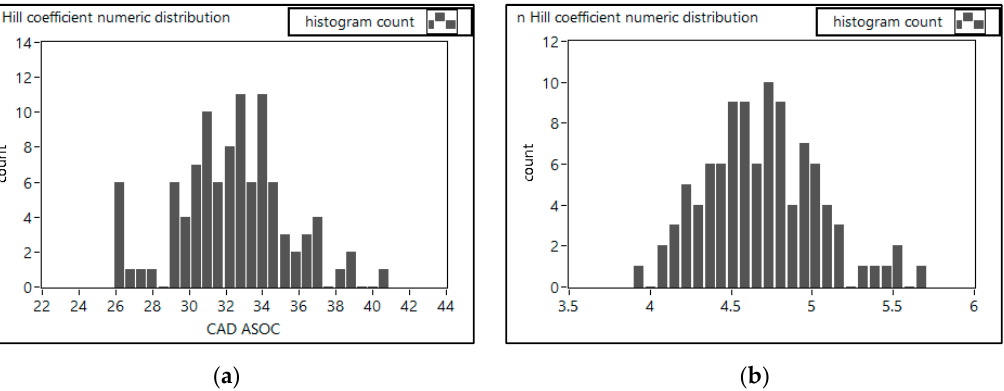
Figure 13. Histograms of Hill coefficients numeric distribution; MAP = 1 bar, n = 3500 rpm, fuel NG. ( a ) δ coefficient (mean value = 32.3 CAD, SD = 3.24 CAD); ( b ) n coefficient (mean value = 4.69, SD = 0.35).